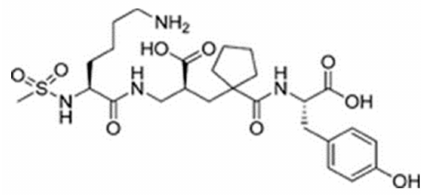
Figure 6. Chemical structure of Sampatrilat